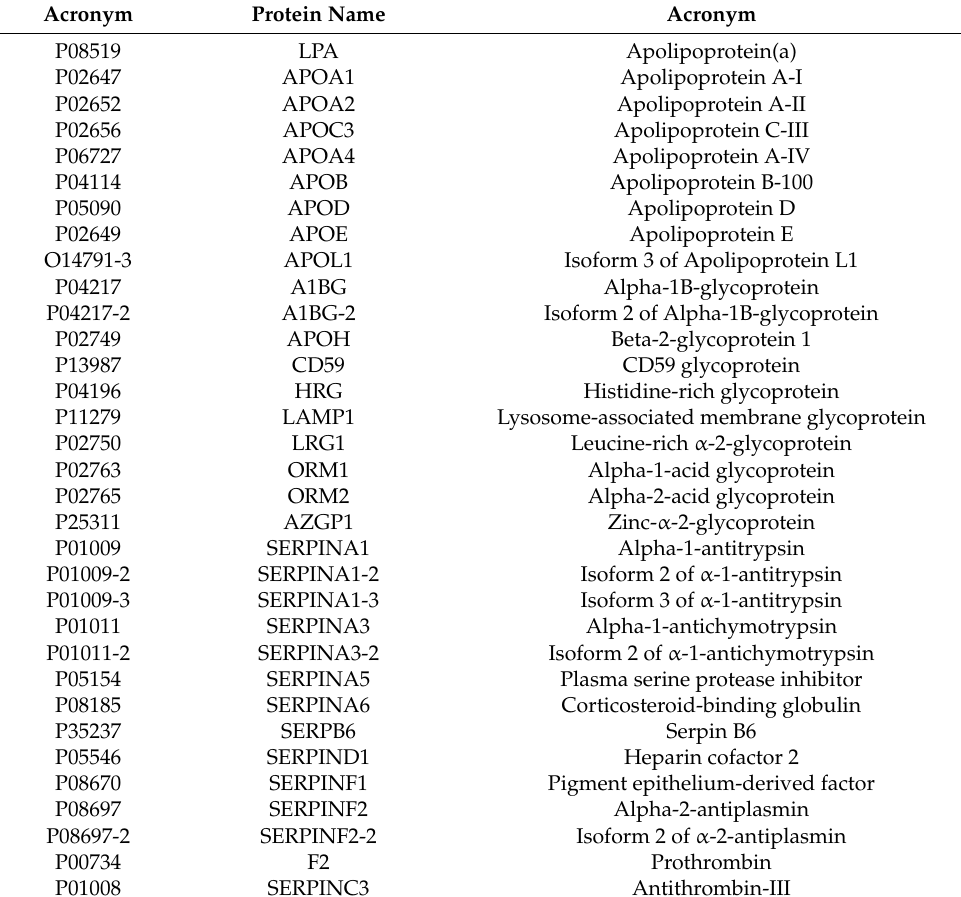
Table A1. Apolipoproteins, glycoproteins, and protease inhibitors in wound fluids.